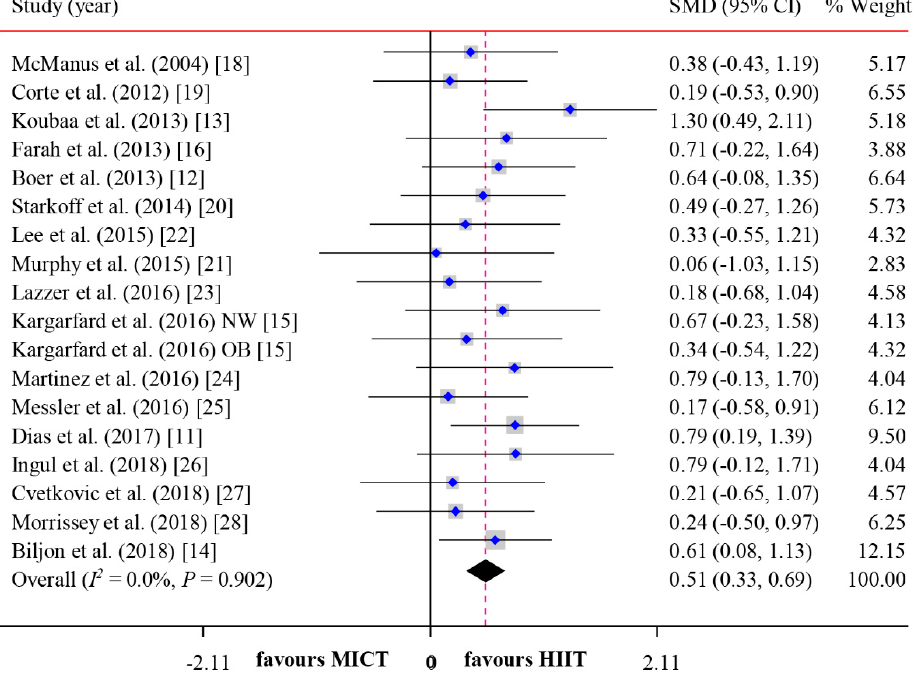
Figure 2. Forest plot for comparing the effects between HIIT and MICT interventions on CRF in children and adolescents by pooling 18 included studies.